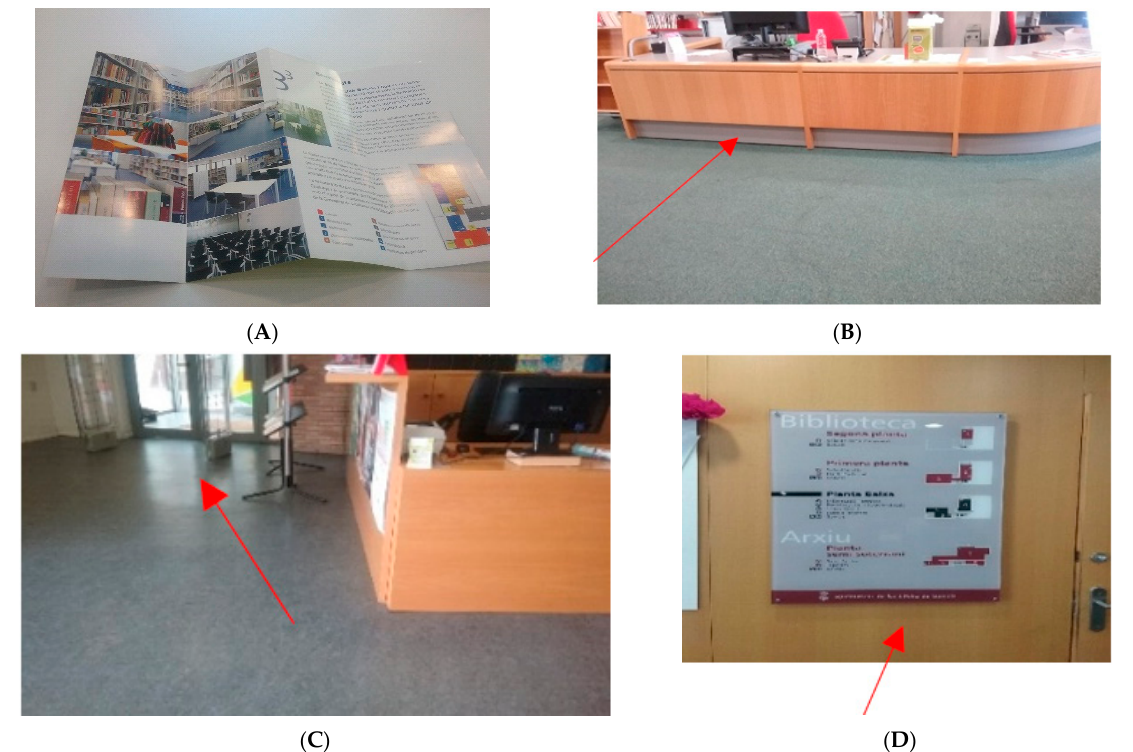
Figure 4. Accessibility challenges identified throughout the project in the library’s physical space and in communication